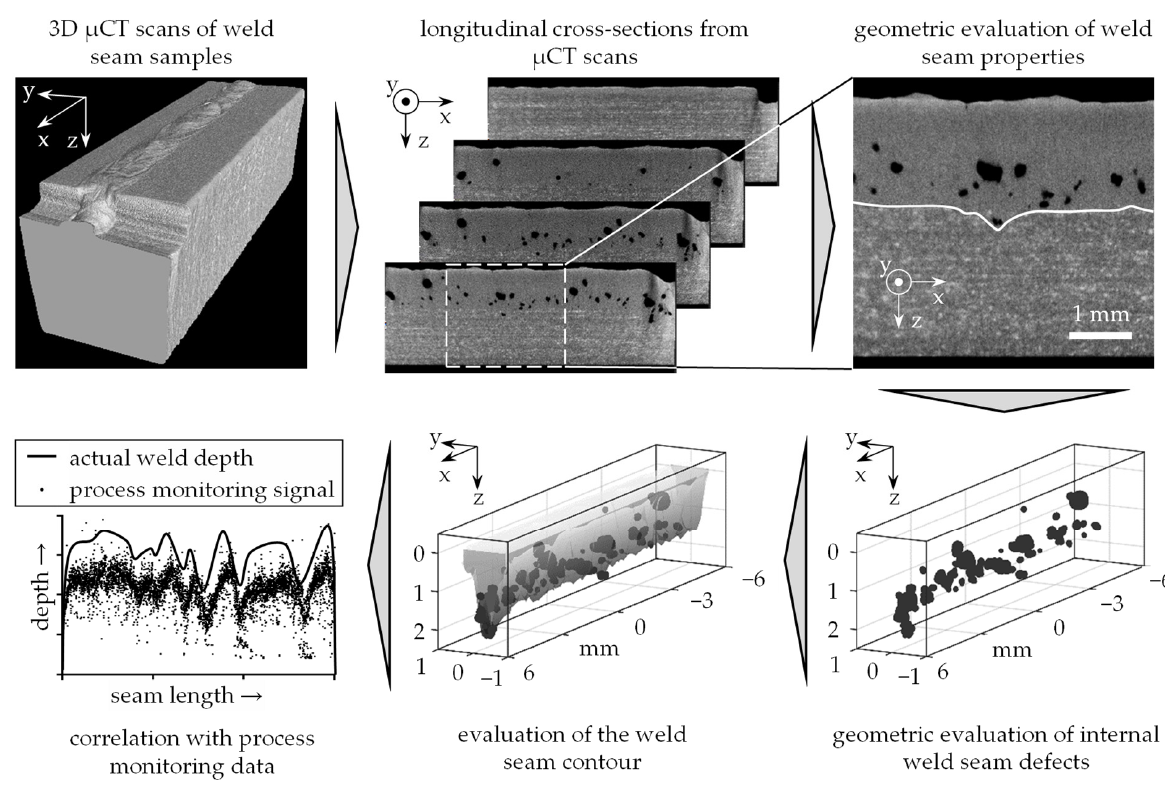
Figure 1. Approach for the development of a 3D characterization method of weld seams concerning internal defects and the weld seam contour as well as for the correlation of the measurement results with inline process monitoring data.